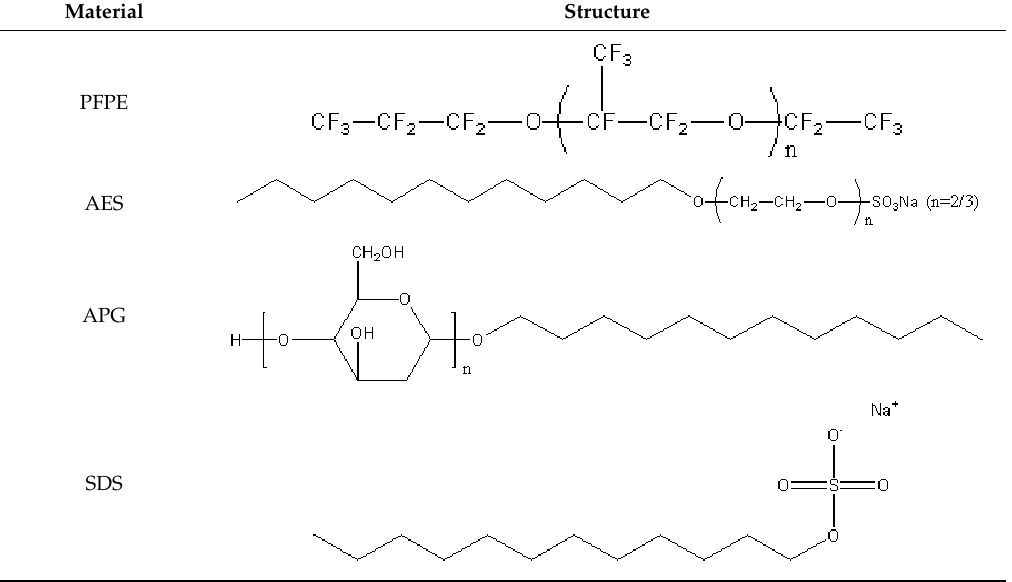
Table 1. Structure of the main Material. PFPE: perfluoropolyether; AES: sodium laureth sulfate; APG: alkyl polyglycoside; SDS: sodium dodecyl sulfate.